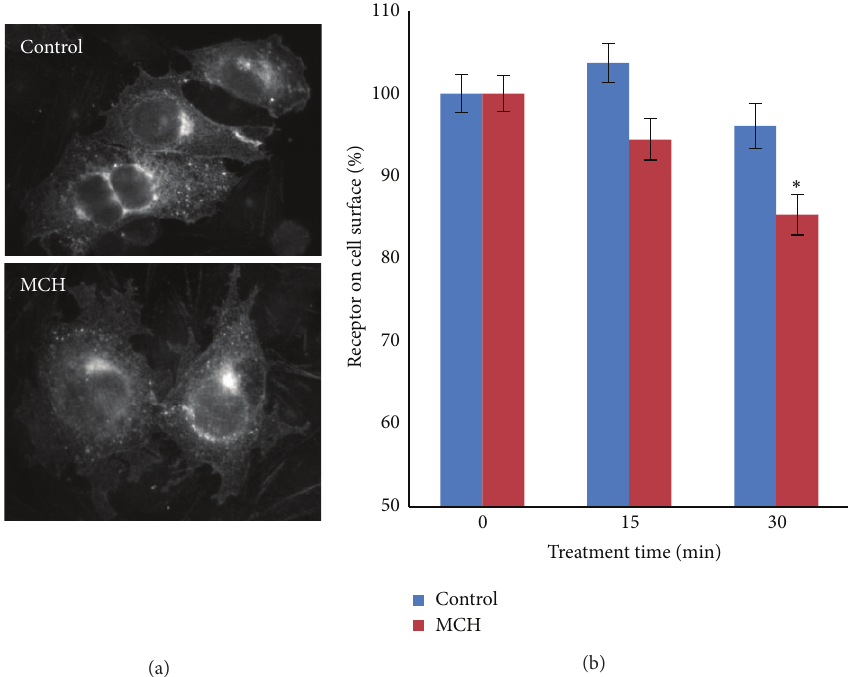
Figure 2: MCH initiates the removal of some MCHR1 from the plasma membrane. BHK-570 cells were transfected with VSVg-tagged MCHR1. (a) Untreated cells and cells that were exposed to 1 𝜇 M MCH for 30min were fixed and immunostained with mouse anti-VSVg primary antibody and goat anti-mouse Alexa Fluor 488 secondary antibody. (b) The loss of MCHR1 from the plasma membrane in response to 1 𝜇 M MCH was measured using a modified cell-based ELISA protocol. Background signal from mock-transfected cells was subtracted. 𝑛 = 18 (6 triplicate experiments). ∗ denotes statistical significance at 𝑃 < 0.0025 when compared to 100% control using Student’s 𝑡